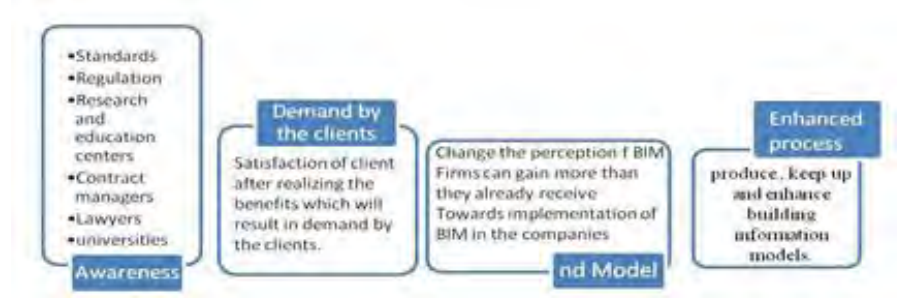
Figure 13. Inputs and outputs of the framework 3. Arrows: the measurements and lesson learned are represented in a closed loop from the performance node back